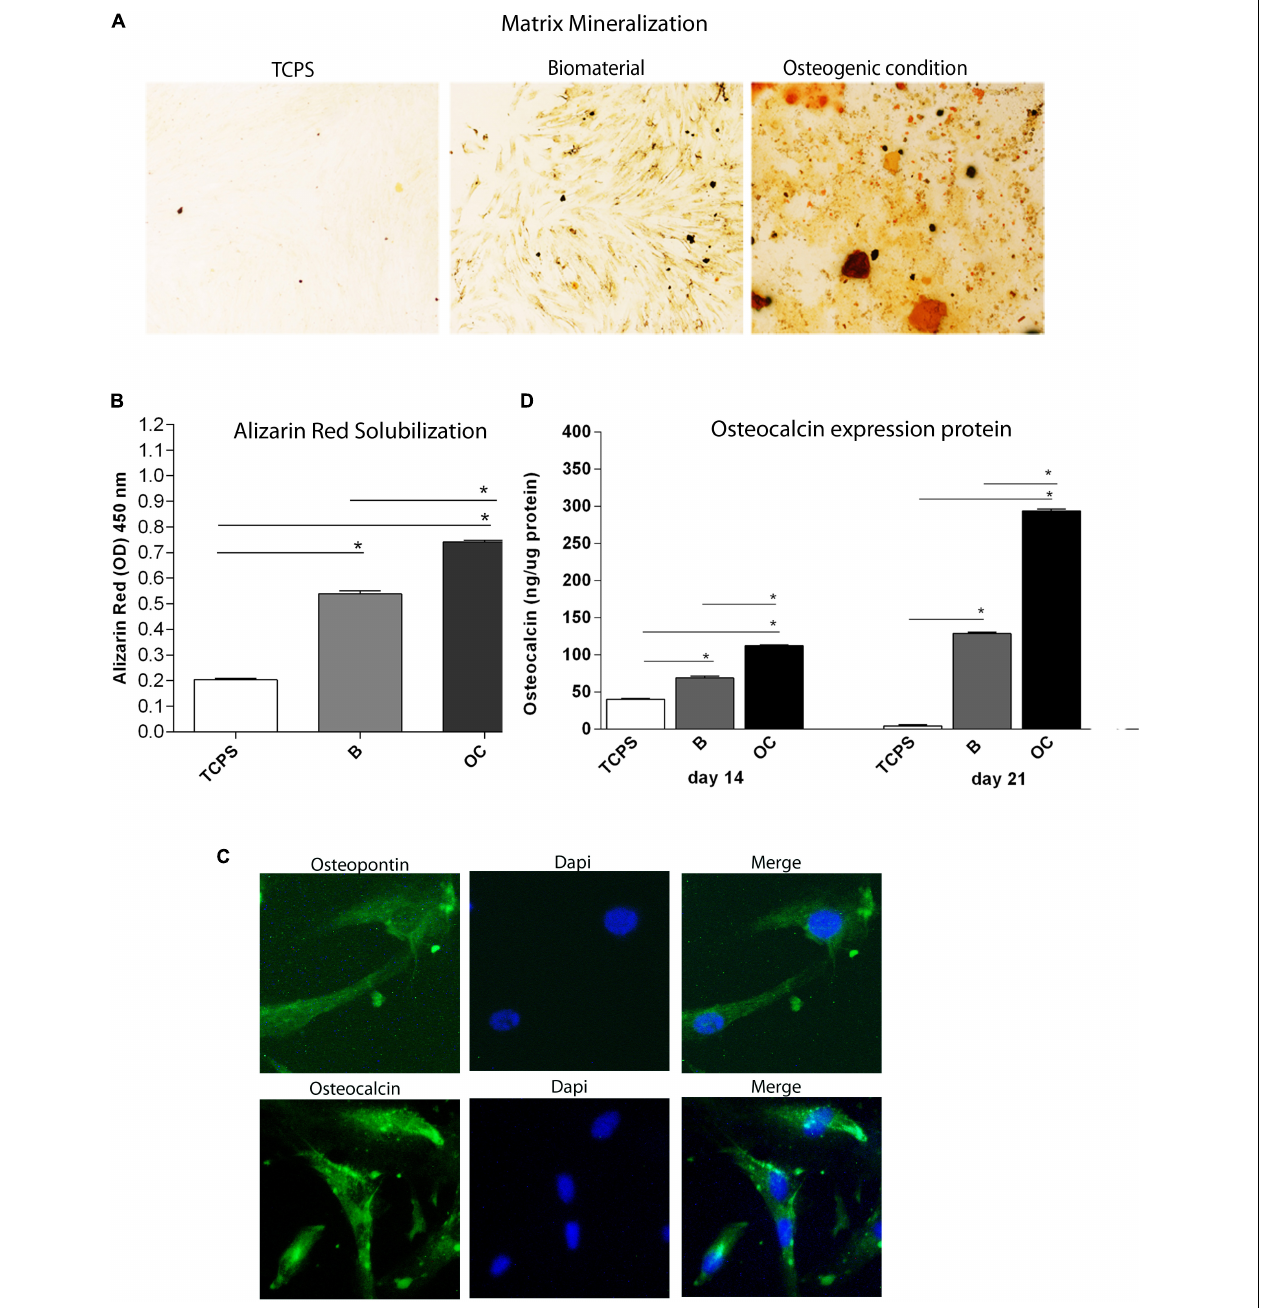
FIGURE 5 | Osteogenic markers in human bone marrow-derived mesenchymal stem cells (hBMSCs) cultured on the biomaterial. (A) Alizarin red staining at day 21 is shown in the panel, in experimental conditions tested. Magnification 4 × . (B) To quantify the amount of alizarin red staining in hBMSCs grown on the biomaterial, cells were eluted with 20% methanol and 10% acetic acid in a water solution and measured spectrophotometrically at 450 nm. Matrix mineralization data are reported as optical density and shown in the graph. (C) Detection of osteopontin and osteocalcin proteins by immunofluorescence staining in hBMSCs, at day 21. Symbols indicate statistical significance (* p < 0.001). Magnification 20 × . (D) The temporal pattern of osteocalcin protein levels detected at different time points, i.e., at days 14 and 21, was quantified by ELISA. Osteocalcin protein was reported as ng of osteocalcin/1 µ g of total protein.